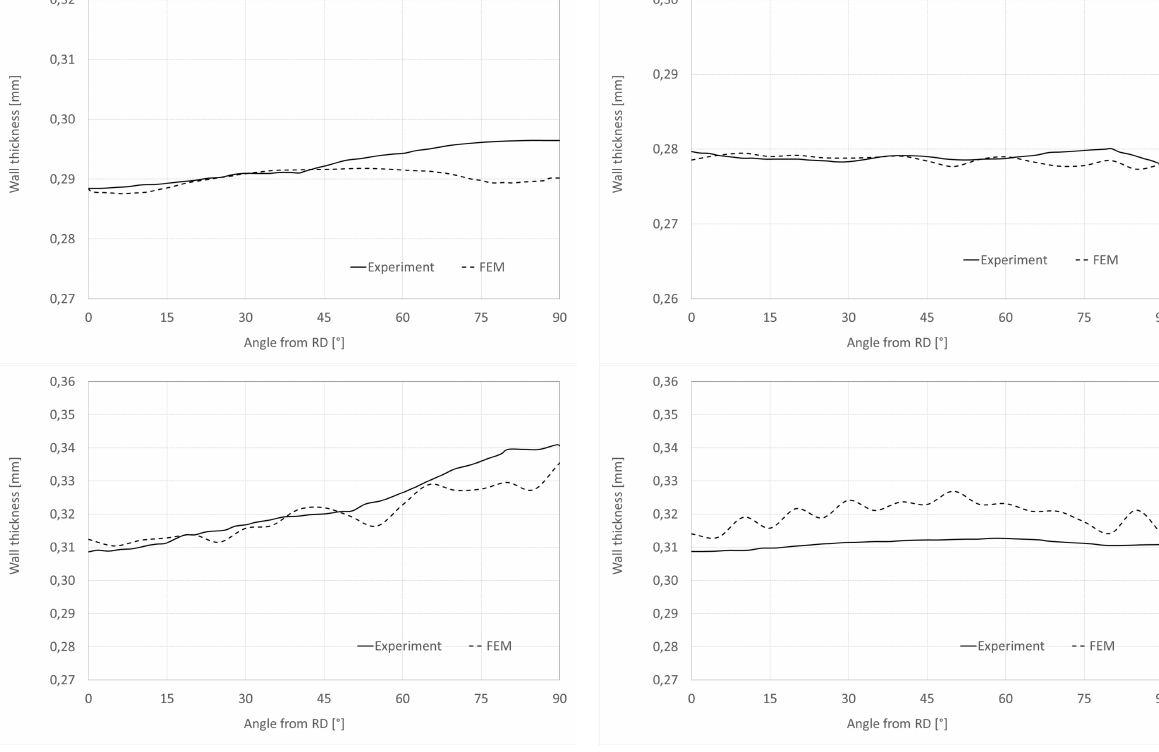
Figure 8: Wall thickness of AA 5352 (left) and TH330 steel (right) in 25 mm (top) and 45 mm (bottom) from cup